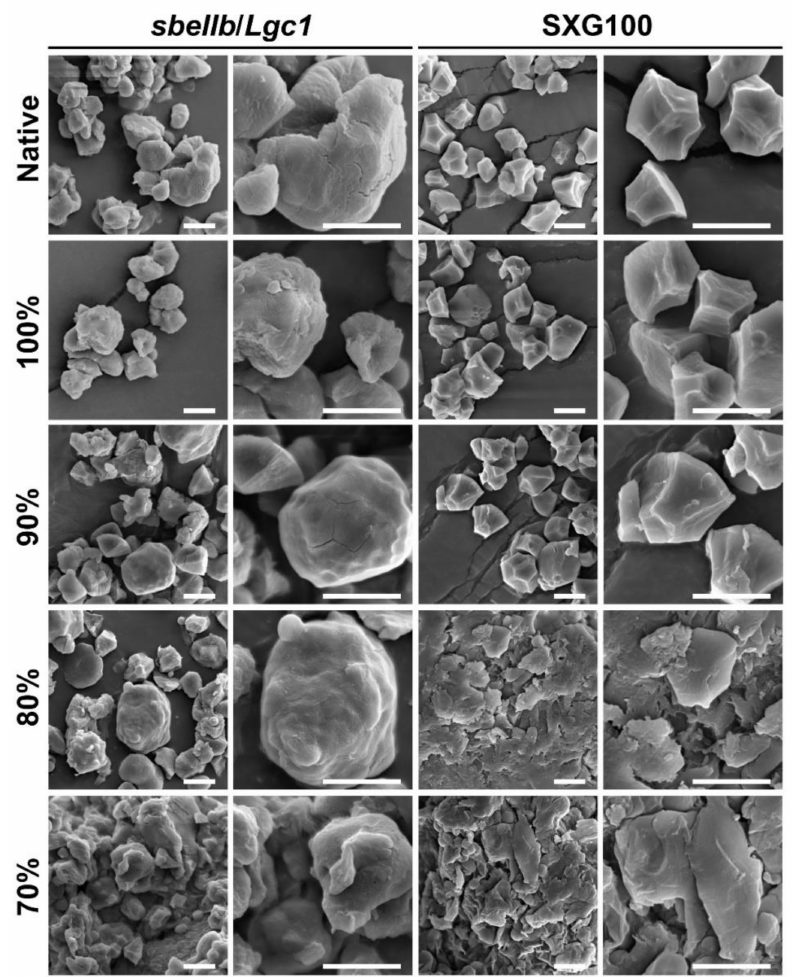
Figure 3. Morphology of starch granules of native and HMT flours observed by the SEM. Bars = 5 µ m. For each sample, the images of representative starch granules with the magnification of 2000 × and 5000 × were